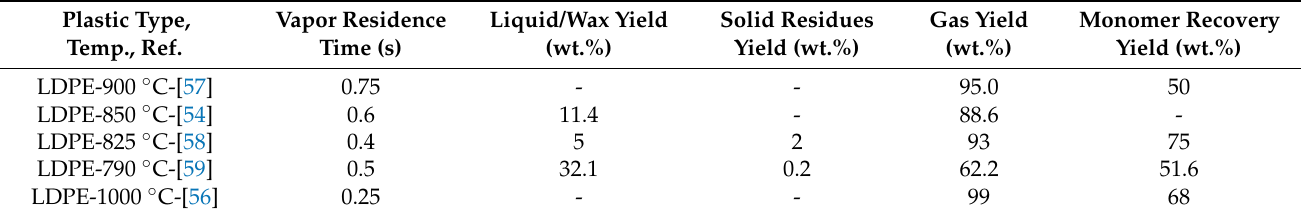
Table 5. Flash pyrolysis of LDPE with different experimental parameters.